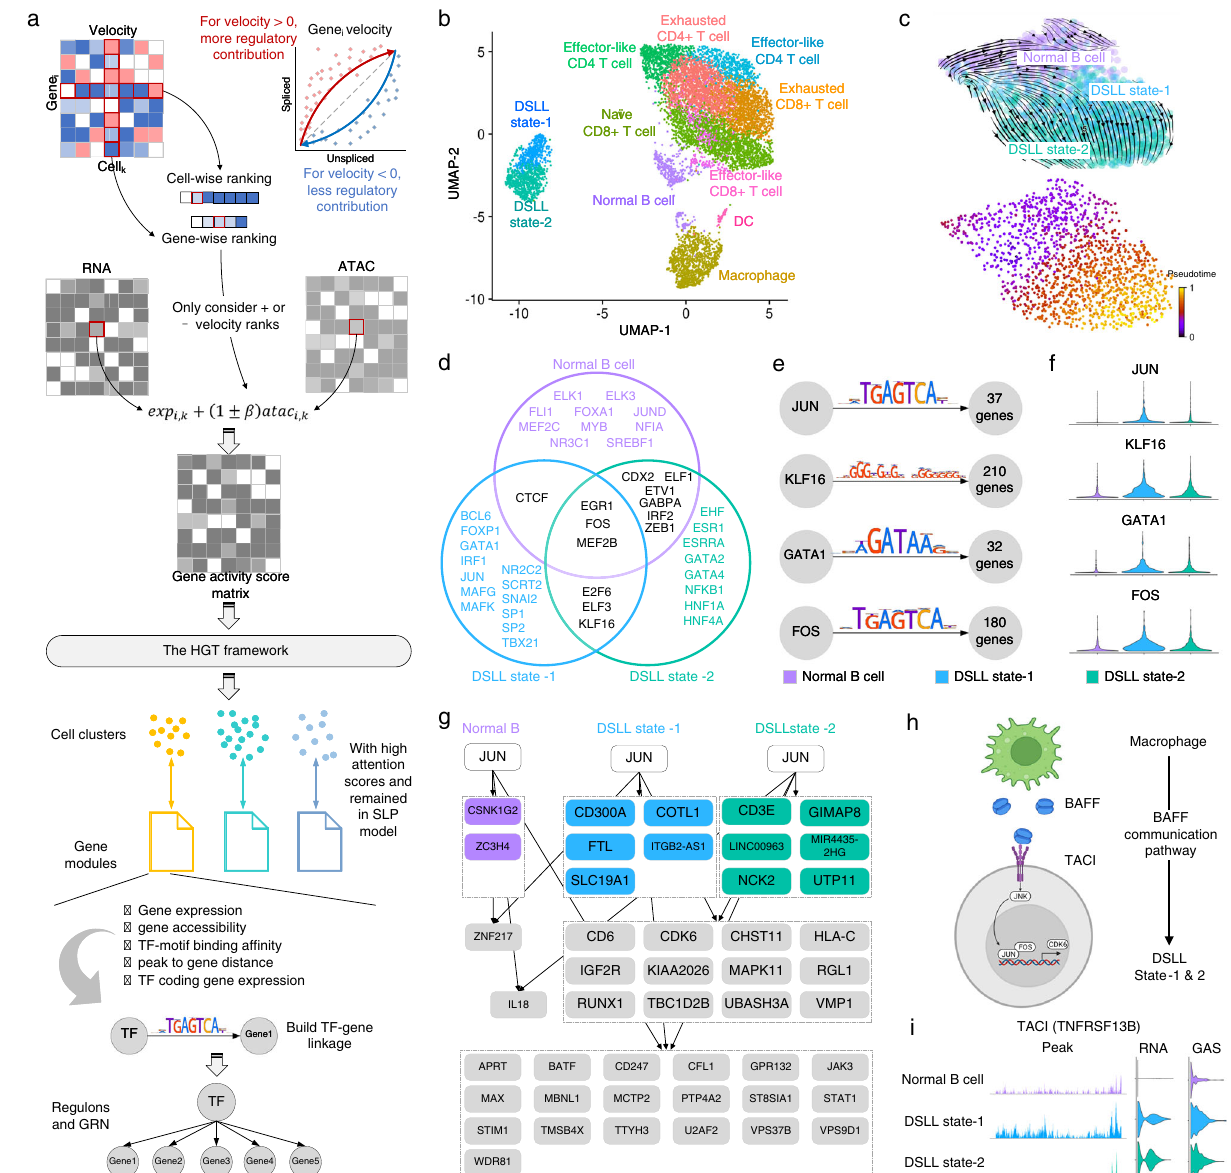
Fig. 5 | DeepMAPS identi fi es speci fi c GRNs in DSLL subnetworks. a Conceptual illustration of DeepMAPS analysis of scRNA-ATAC-seq data. Modalities are fi rst integrated based on a velocity-weighted balance. The integrated GAS matrix was then used to build a heterogeneous graph as input into the HGT framework. The cell cluster and gene modules with high attention scores were then used for building TF-gene linkages and determining regulons in each cell cluster. b The UMAP shows the clustering results of DeepMAPS. Cell clusters were manually annotatedbasedoncuratedmarkergenes. c Theobservedandextrapolatedfuture states (arrows) based on the RNA velocity of the normal B cell and the two DSLL states are shown (top panel). Velocity-based trajectory analysis shows the pseu- dotimefromthetoptothebottomright(bottompanel). d Selected20TFineachof the three clusters, representing the top 20 regulons with the highest centrality scores. Colors represent regulons uniquely identi fi ed in each cluster or shared